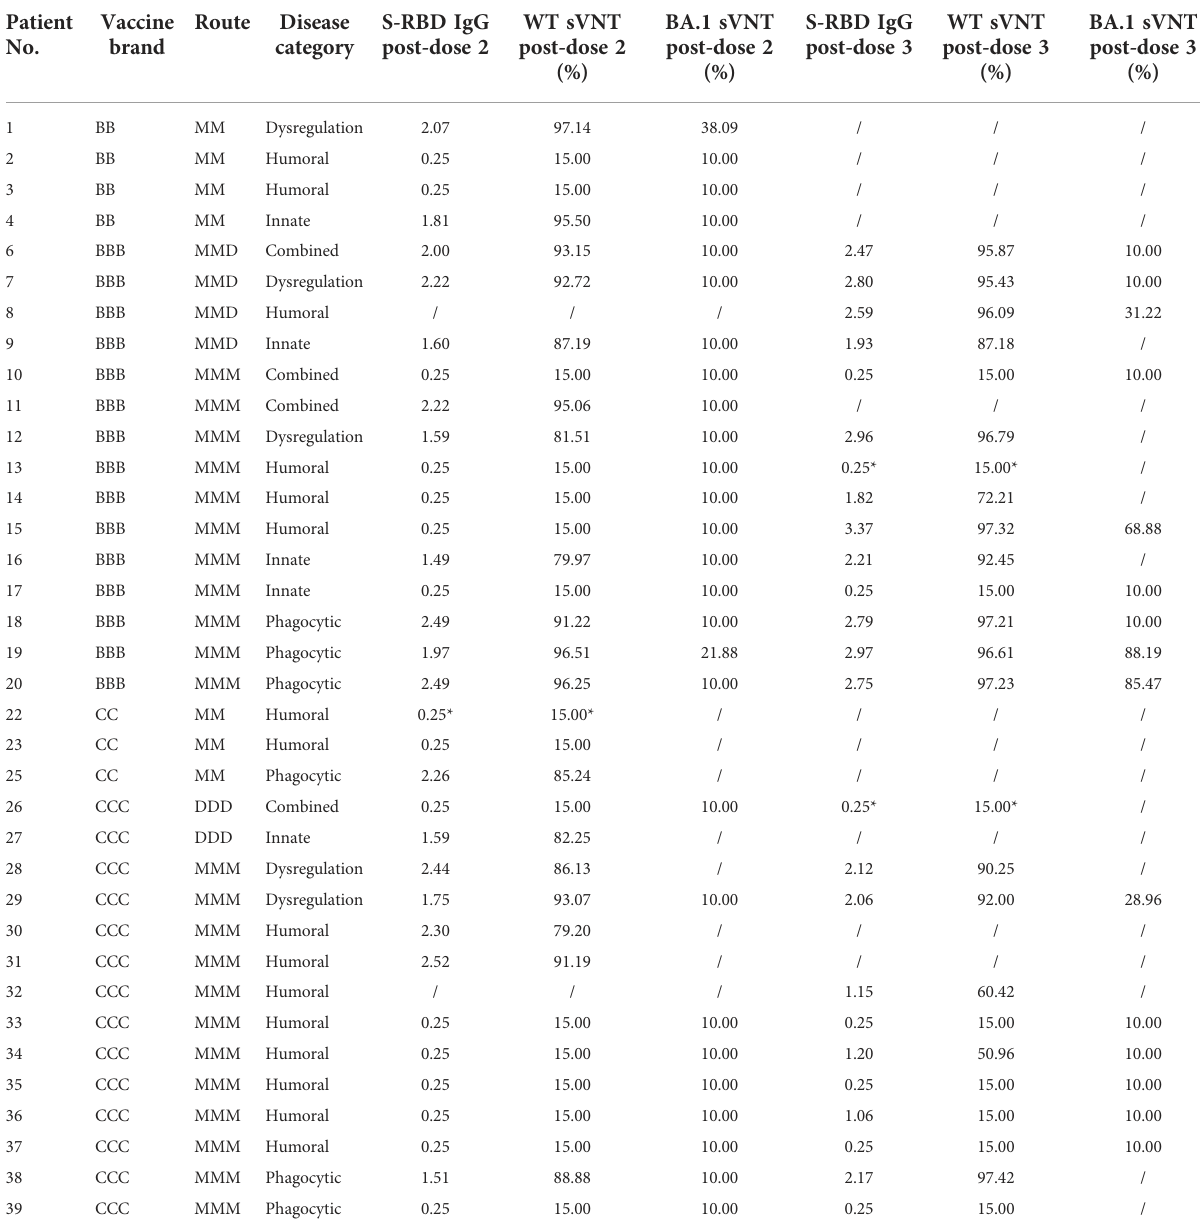
TABLE 2 Antibody responses in IEI patients. Patient